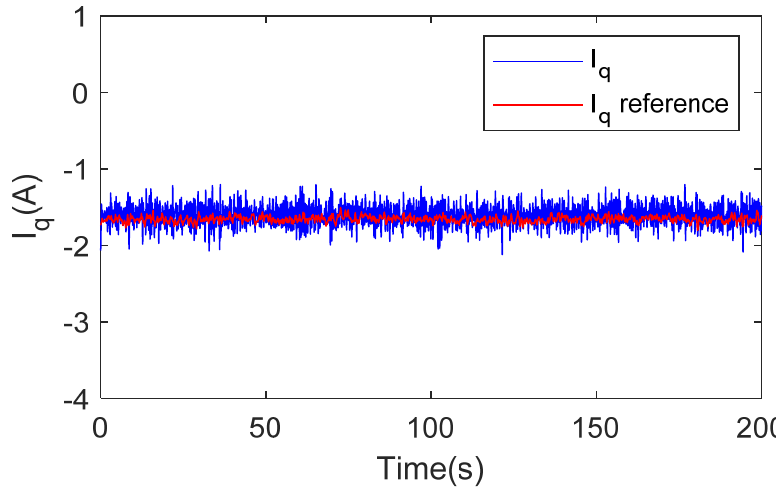
Figure 14. i q current control result with a constant reference.